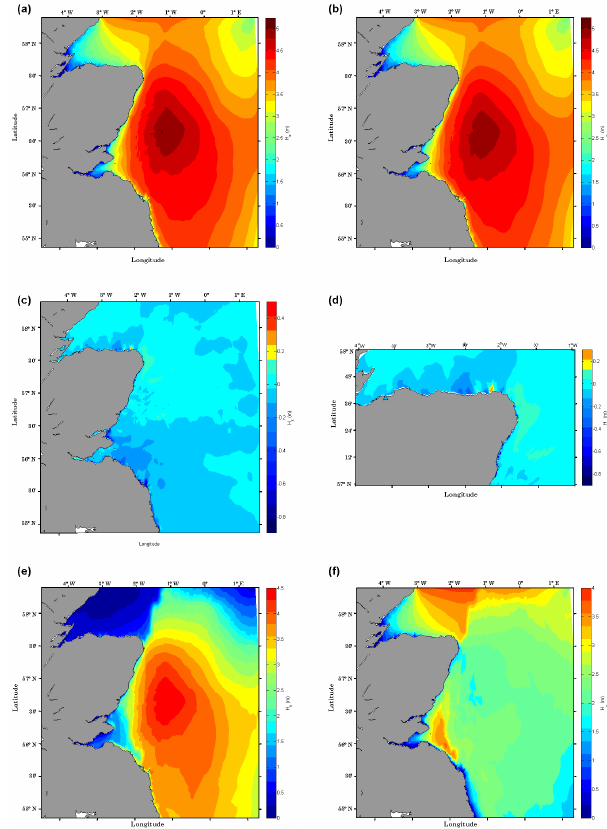
Figure 10. The modelled H s on the east coast of Scotland at 19:00UTC on 26 February 2010: (a) coupled model (mean WCI included), (b) uncoupled model (mean WCI not included), (c) dif- ference between coupled and uncoupled models, (d) difference be- tween coupled and uncoupled models in the Moray Firth area, (e) windsea waves, (f) swell